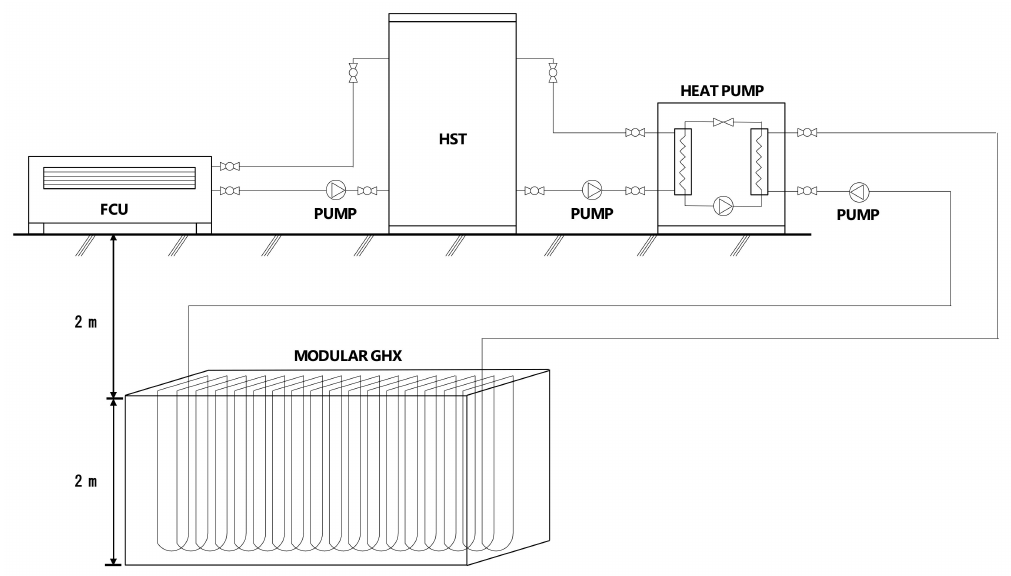
Figure 2. Modular ground heat exchanger (GHX)